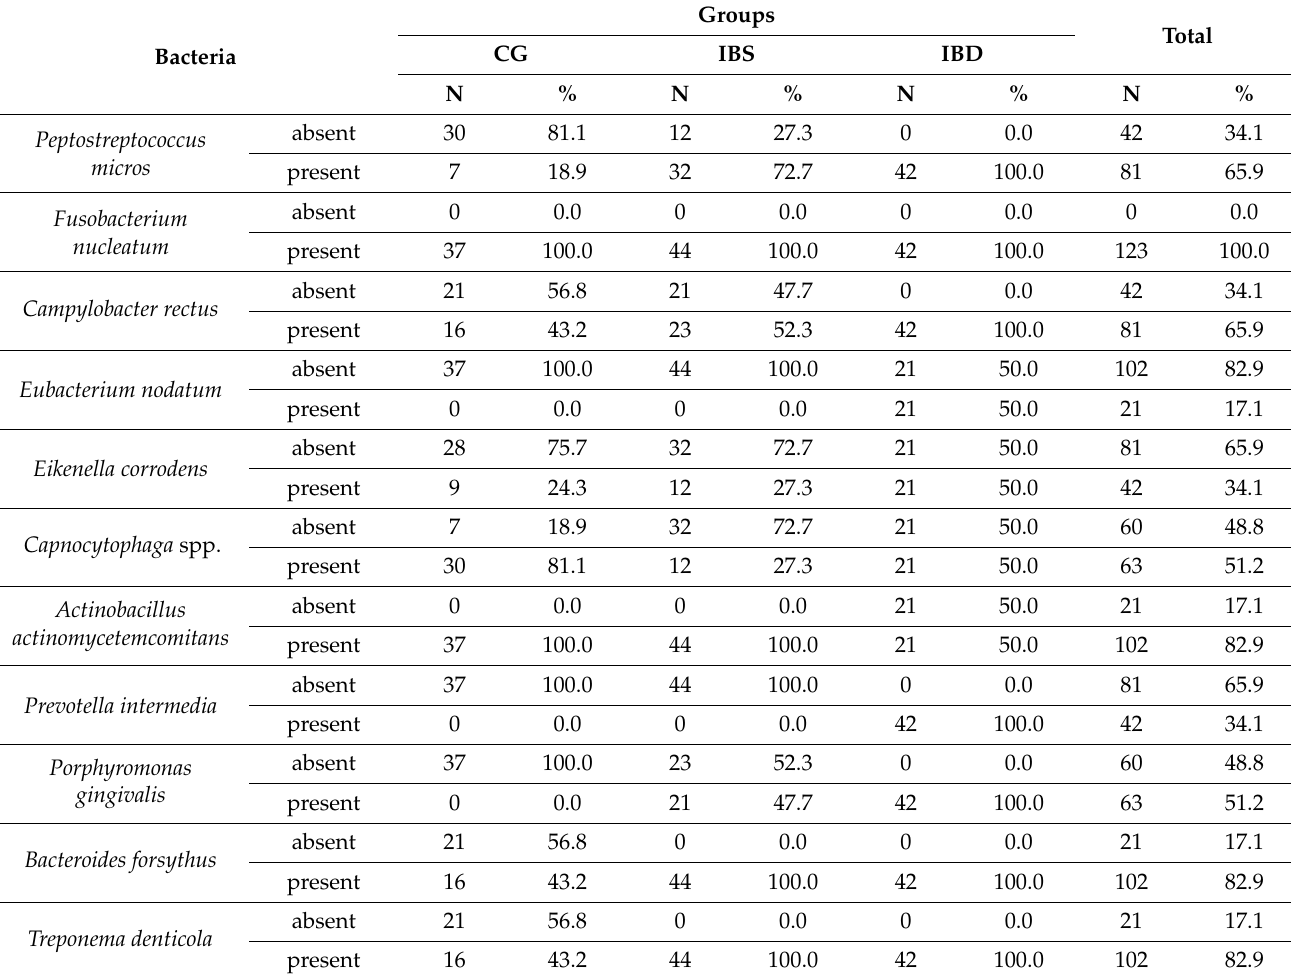
Table 3. Descriptive presentation of the presence of bacteria in the three research groups.